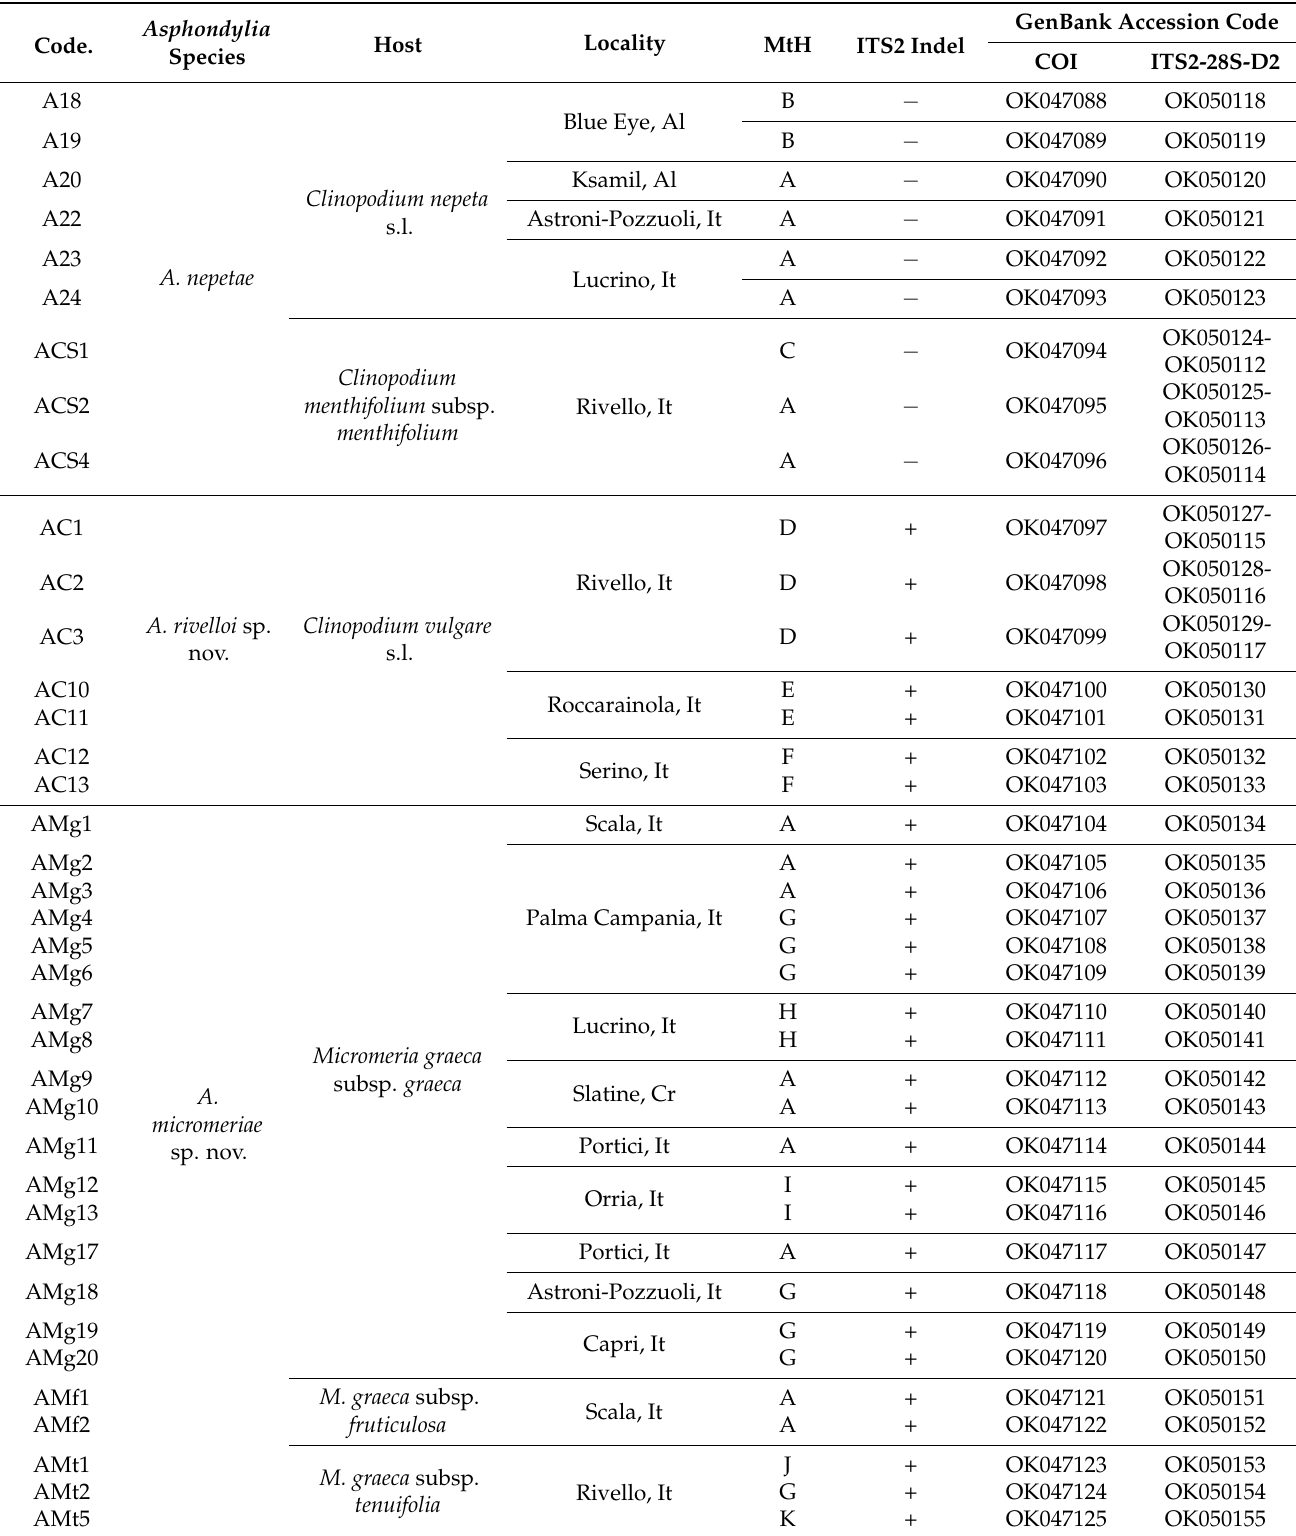
Table 1. List of specimens used for the molecular study. It: Italy; Pl: Poland; Cr: Croatia; Al: Albania; MtH: mitochondrial haplotype; +, − indicate presence or absence of the ITS2 indel, respectively.